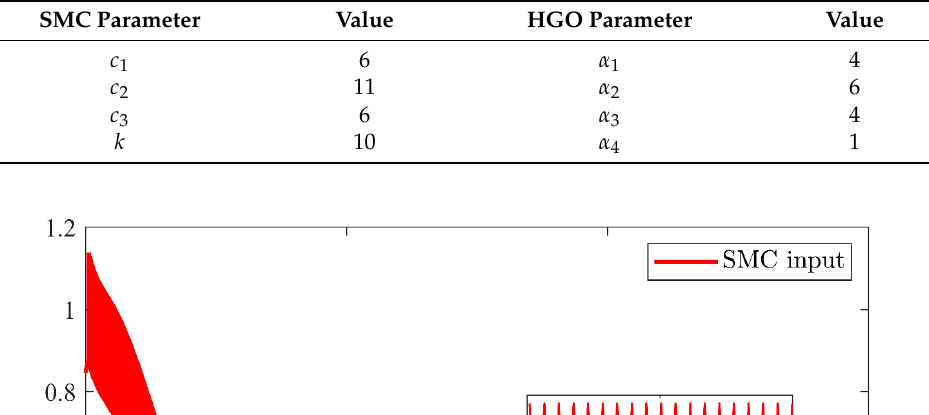
Figure 6. SMC control input with chattering (using signum function). Table 2. SMC and HGO parameters.